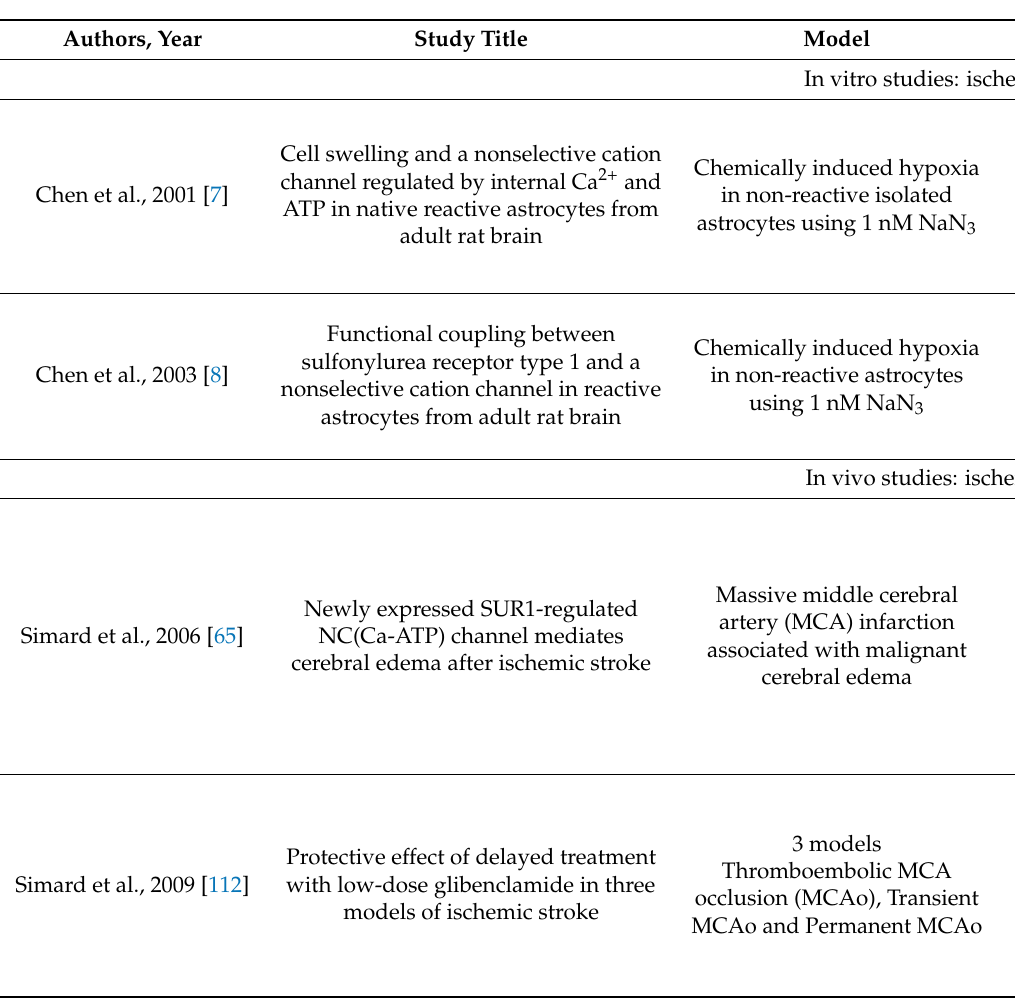
Table 2. Pre-clinical and clinical studies evaluating SUR1 inhibition for ischemic